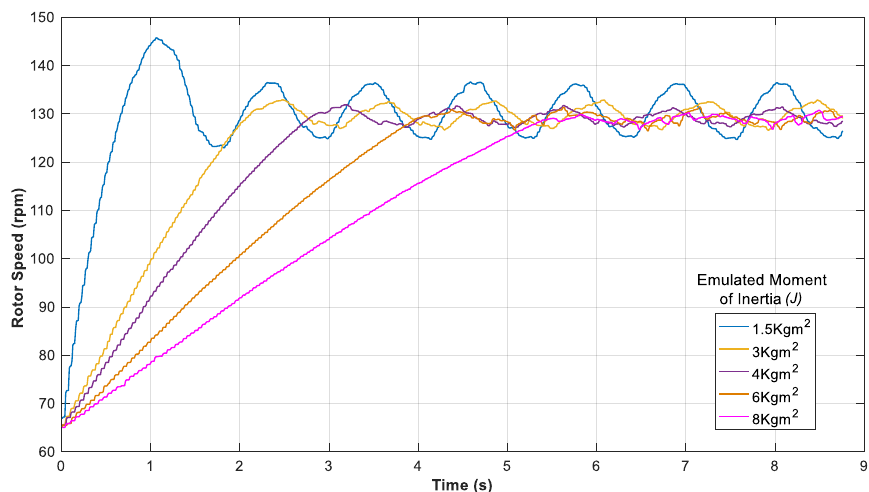
Figure 16. Experimental results of the dynamic of the emulator system for different values of J’.